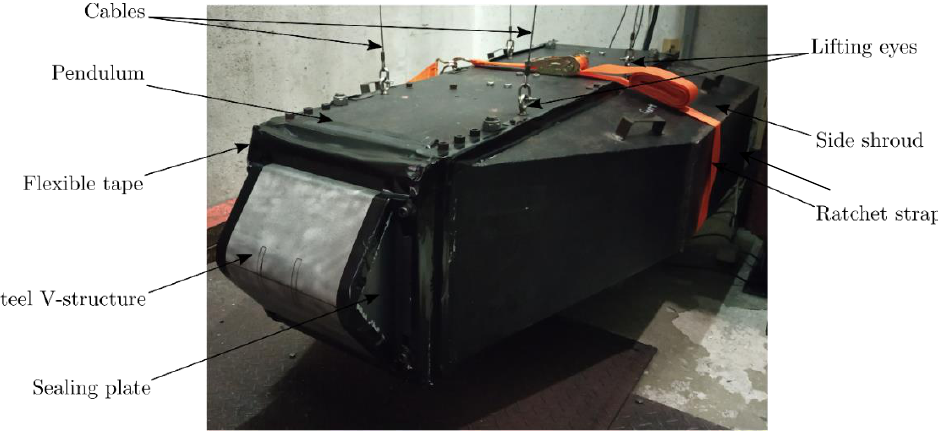
Figure 3. Photograph of the blast test arrangement, showing the V-structure specimen, mounting frame and pendulum system, prior to